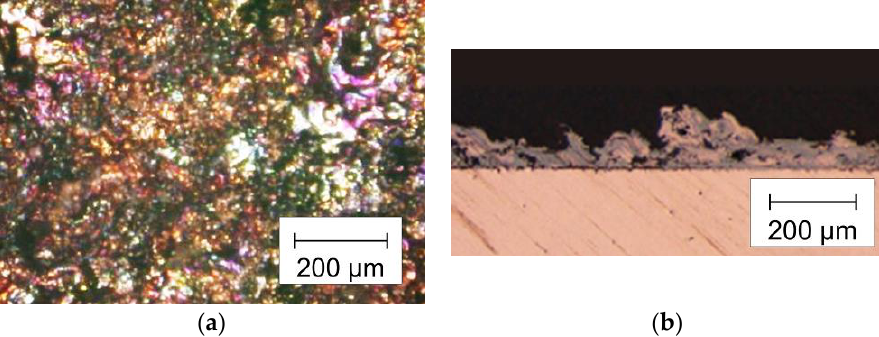
Figure 3. Microphotographs of the thermal spray coating. ( a ) Top view. ( b ) Cross-sectional view.